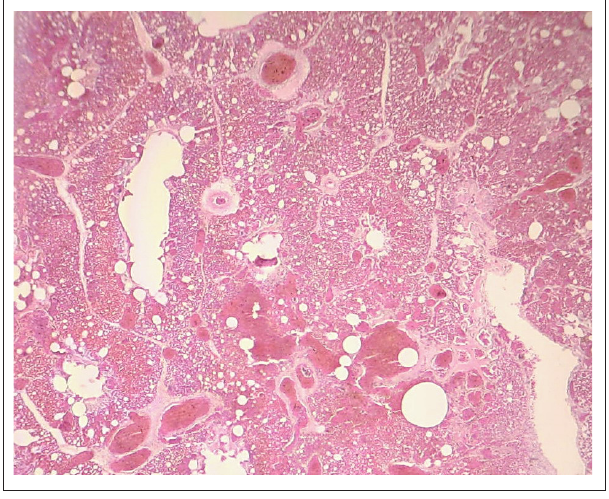
Haematoxylin and eosin stain × 170. FIGURE 2: Hyperplasia of the epithelial layer cells and infiltration of lymphocytes and heterophils in the trachea, 6 days post-inoculation.